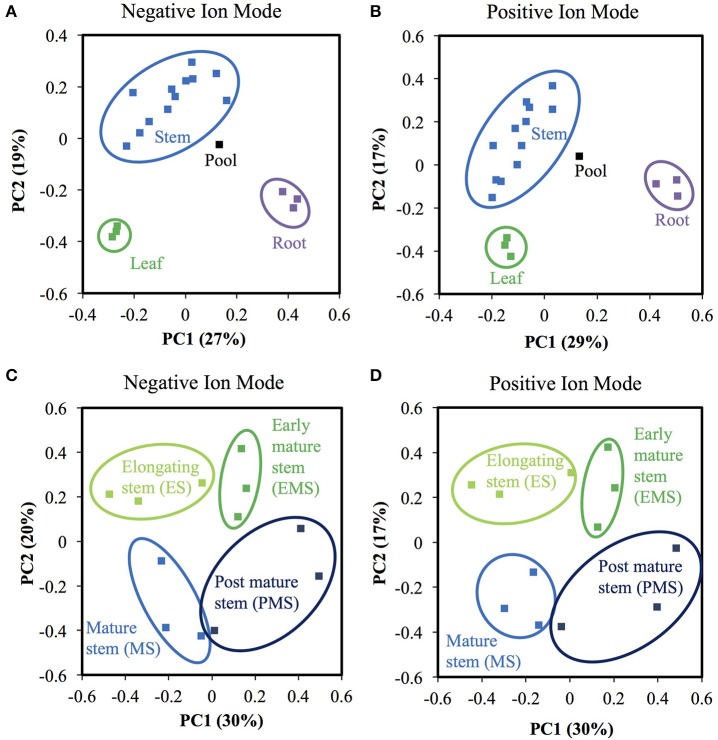
Methanol extracted metabolite profiles differ among rice organs and internode II developmental stages. (A,B) Principal component analysis (PCA) of samples from different organs. Leaf samples are represented by green symbols, root are purple, stem are blue. The pool sample is black. (A) Negative ion mode. (B) Positive ion mode. (C,D) PCA of stem samples of different developmental stages. Light green, green, blue, and dark blue represent elongating stem internode (ES), early mature stem internode (EMS), mature stage stem internode (MS), and post mature stem internode (PMS), respectively. (C) Negative ion mode. (D) Positive ion mode.